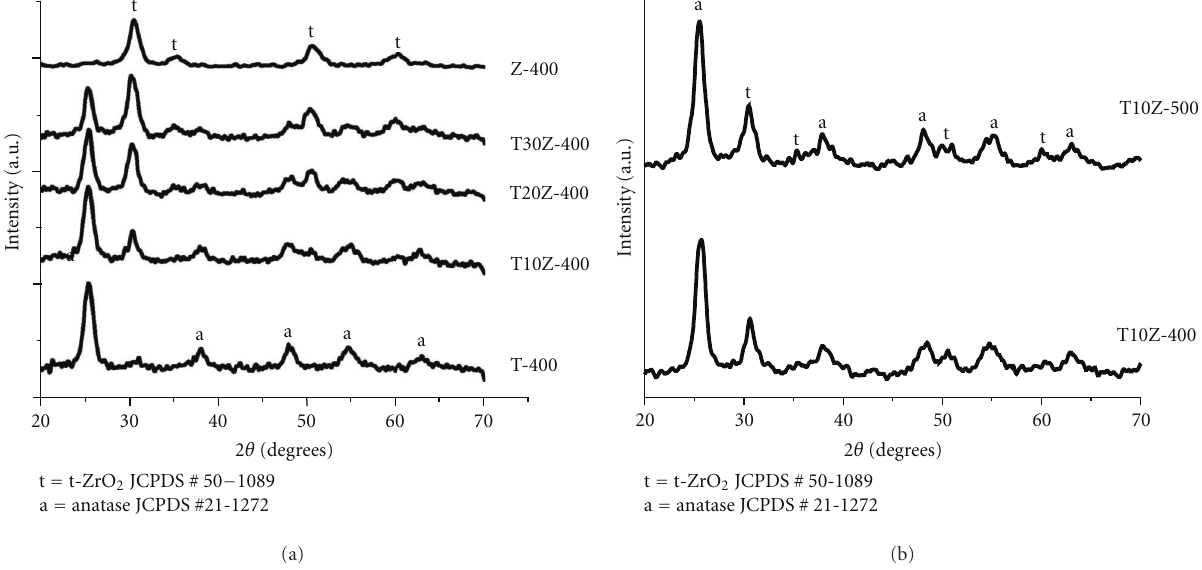
Figure 3: X-ray di ff raction patterns (a) of T10Z-400, T20Z-400, T30Z-400, T-400, and Z-400 samples and (b) for sample T10Z calcined at 400 and 500 ◦ C.